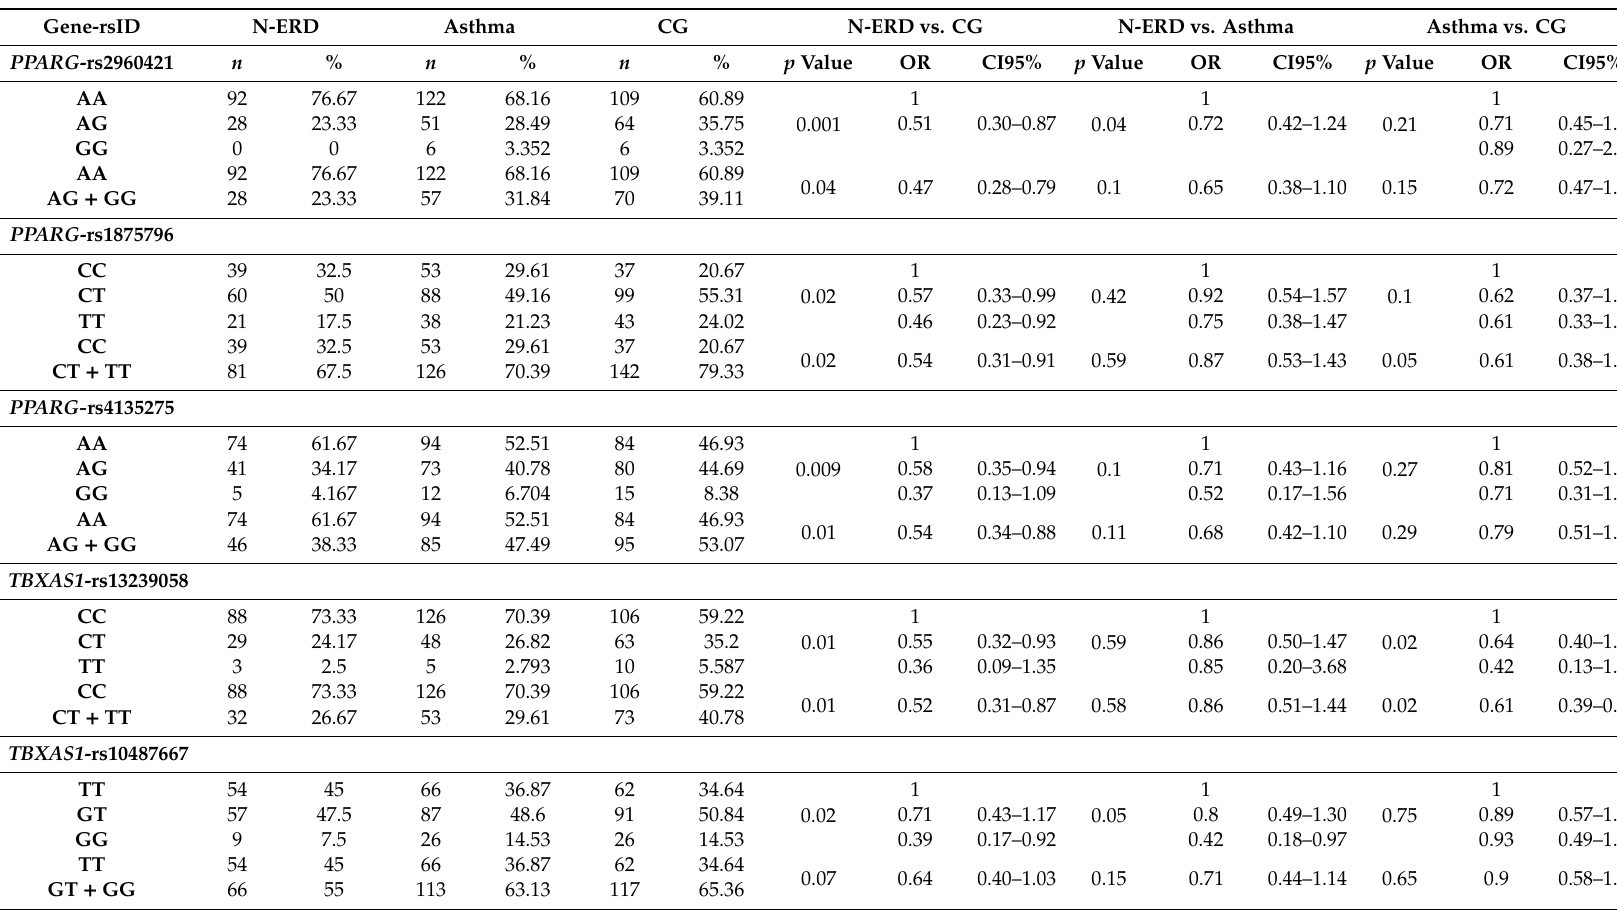
Table 4. Genotype frequencies of single nucleotide polymorphisms (SNPs) associated with the first stage